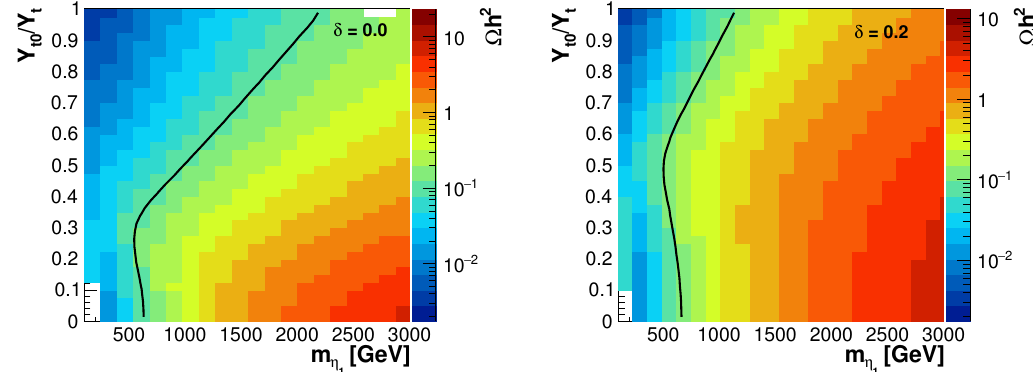
Figure 5 . Plot of the thermal relic density (cid:10) h 2 of the DM candidate (cid:17) 1 in the plane of its mass and Y t 0 =Y t for (cid:14) = 0 (left) and (cid:14) = 0 : 2 (right). The black lines correspond to the observed value of DM relic density (cid:10) h 2 = 0 : 1198. The plots are symmetric under change of sign of Y t 0 , so we only show positive